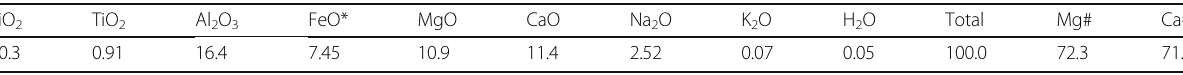
Table 1 Primary MORB composition from Kinzler and Grove